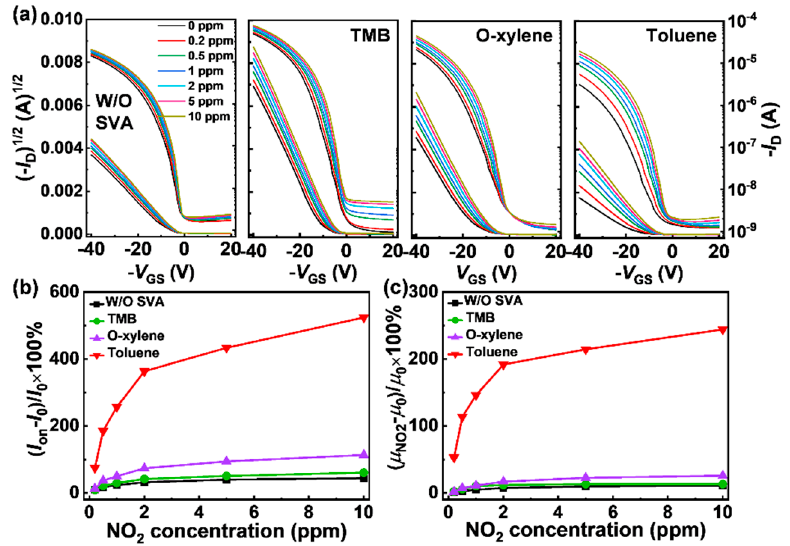
Figure 2. ( a ) Transfer curves of the OTFTs with different processes at room temperature ( V DS = − 40 V). Variation of OTFT parameters of the sensors at different NO 2 concentrations (0.2–10 ppm), ( b